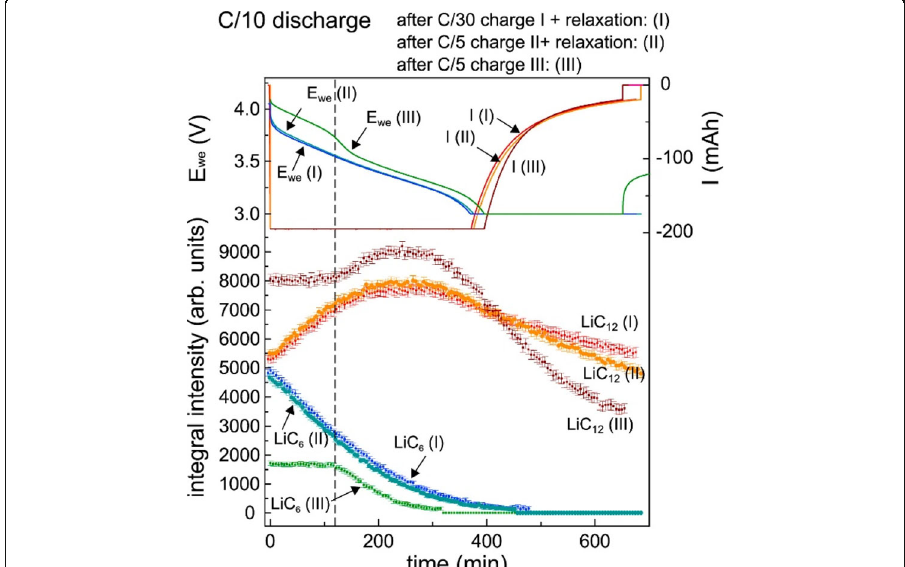
Fig. 10 Integral reflection intensities of LiC 12 and LiC 6 during C/10 discharge after C/30 charge (red/blue), C/5 charge + rest period (orange/cyan) and C/5 charge without rest period (green/pink). Voltage (working potential Ewe) and current during discharge (top) (Zinth et al. 2014) (reproduced with permission of